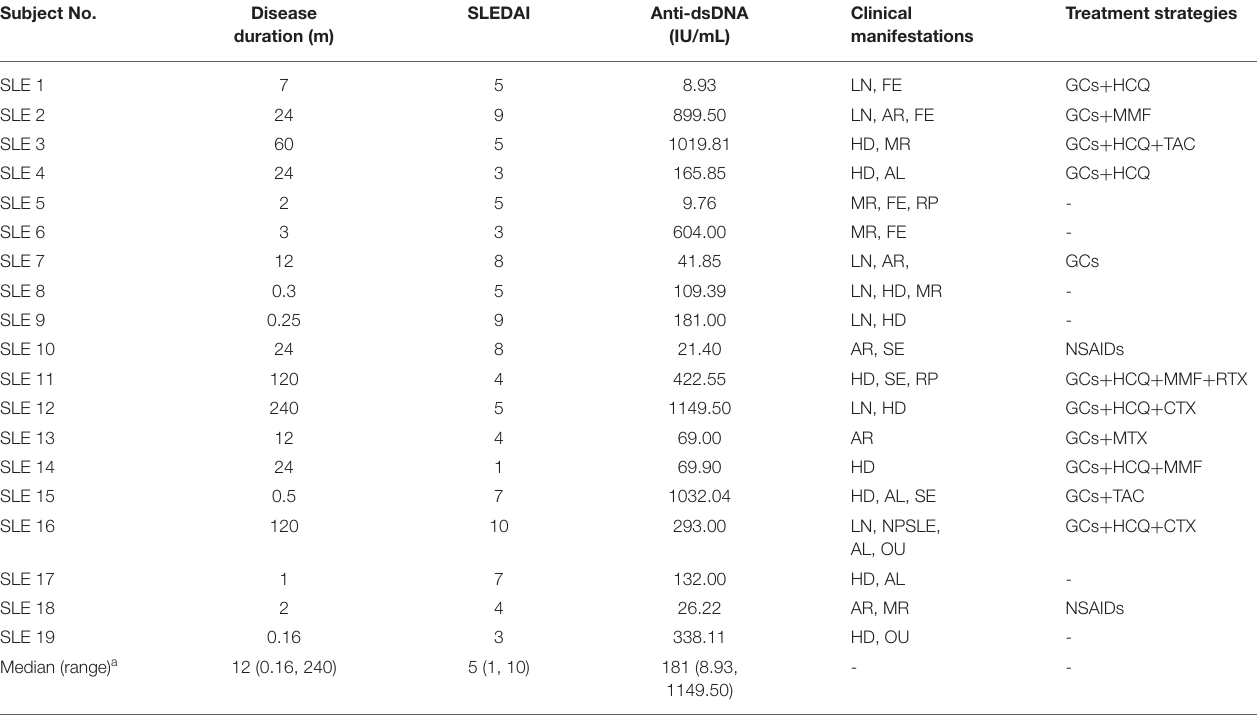
TABLE 2 | Clinical and immunological features of SLE patients. Subject